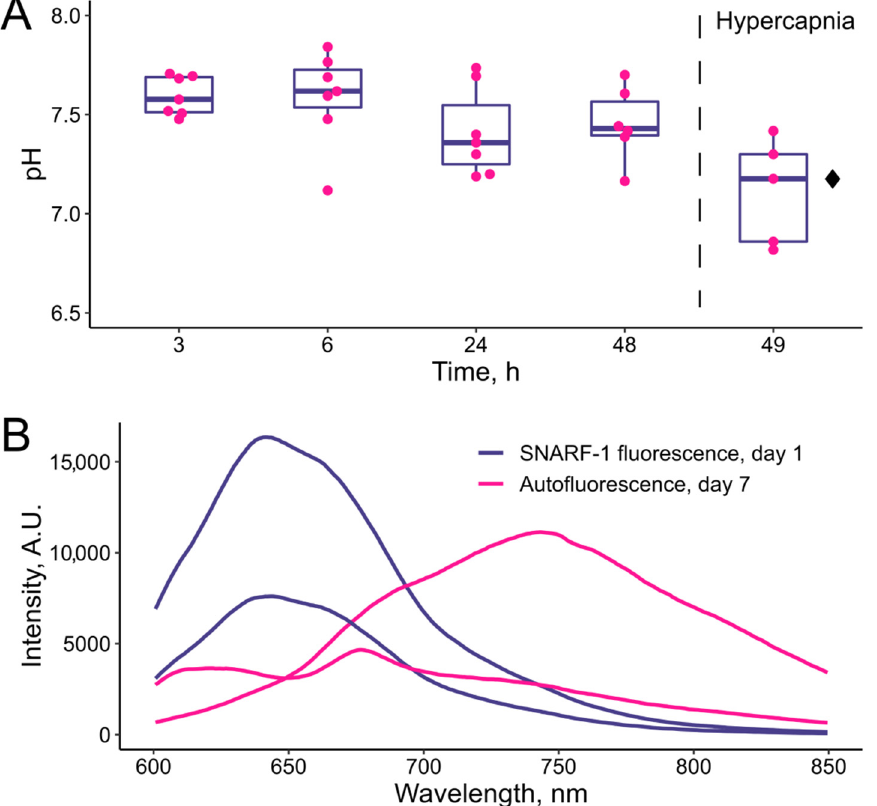
Figure 6. Testing long-term functionality of implanted PAAH + PMs with pH-sensitive SNARF-1. ( A ) pH monitoring in fish muscles using SNARF-1 spectra for two days at normal CO 2 concentration in the water (2 mg/L) and after 1 h exposure to high CO 2 (97 mg/L). Dots indicate individual measurements. Black diamond indicates statistically significant difference from 48 h according to the paired Student’s t -test with p < 0.05. ( B ) Example spectra of SNARF-1 immediately after implantation of PAAH + PMs and example spectra of autofluorescence (possibly combined with SNARF-1 fluorescence) at the injection site 7 days later. All spectra were obtained from the same individual.